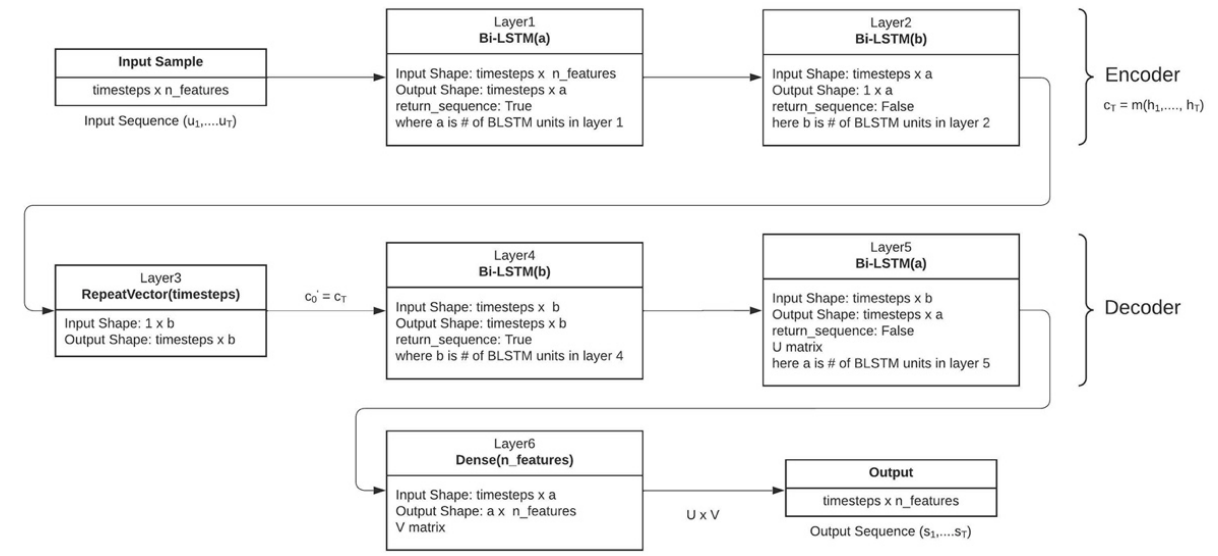
Figure 7. Encoder–Decoder Architecture.